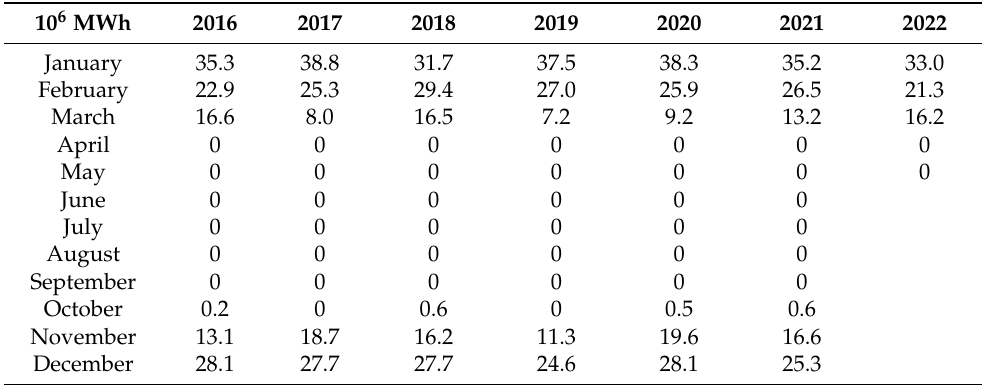
Table 4. Withdrawal to Underground Gas